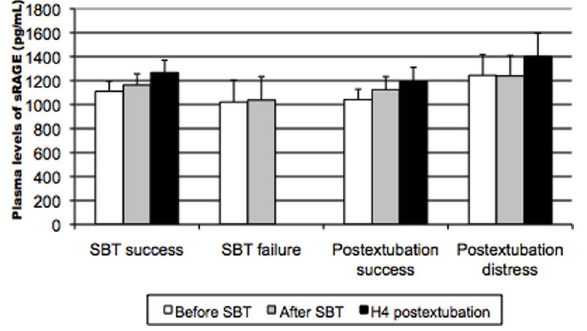
Figure 2. Plasma levels of sRAGE (in pg/mL) measured before, immediately after a spontaneous breathing-trial (SBT) and 4 hours after extubation, and their relations to SBT failure, postextubation distress and successful weaning.